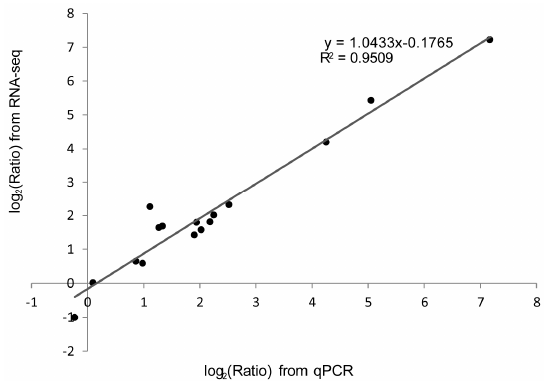
Figure 11. Correlation analysis of fold change data between qPCR and RNA-seq. Scatterplots were generated by the log 2 expression ratios from RNA-seq ( x -axis) and qPCR ( y -axis). Data from qPCR are means of three replicates, while data from RNA-seq are means of two replicates. The reference line represents the linear relationship between the results of RNA-seq and qPCR.